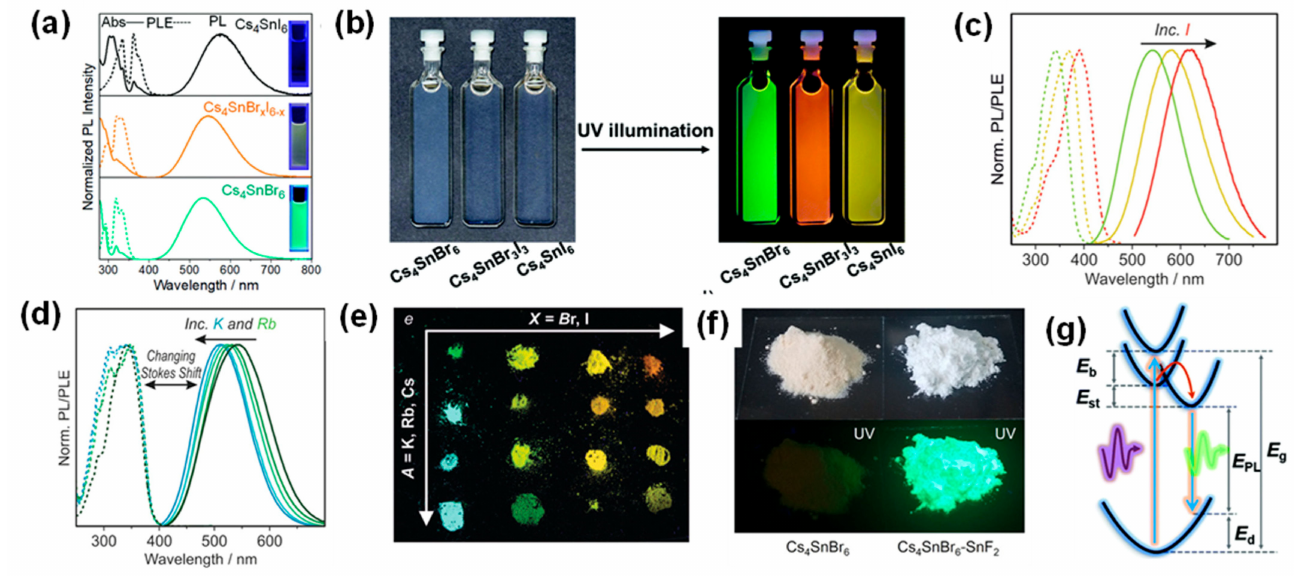
Figure 3. ( a ) Absorbance, photoluminescence excitation and emission spectra of Cs 4 SnBr 6 Cs 4 SnBr 6 I 6–x and Cs 4 SnI 6 . Reproduced with permission from [28], Copyright 2020, The Royal Society of Chemistry. ( b ) Normal and UV light images of Cs 4 SnBr 6 , Cs 4 SnBr 3 I 3, and Cs 4 SnI 6 . Reproduced with permission from [29], Copyright 2022, The Royal Society of Chemistry. ( c ) Photoluminescence excitation and emission spectra of Cs 4 Sn(Br,I) 6 . ( d ) Photoluminescence excitation and emission spectra of Cs 4—x A x Sn(Br,I) 6 , where A = K + , Rb + . ( e ) UV light image of Cs 4–x A x Sn(Br, I) 6 powders. Reproduced with permission from [27], Copyright 2022, Wiley-VCH. ( f ) Normal and UV light image of Cs 4 SnBr 6 and Cs 4 SnBr 6 –SnF 2 . Reproduced with permission from [26], Copyright 2022, Wiley-VCH. ( g ) Schematic illustration of STE emission. Reproduced with permission from [29], Copyright 2022, The Royal Society of